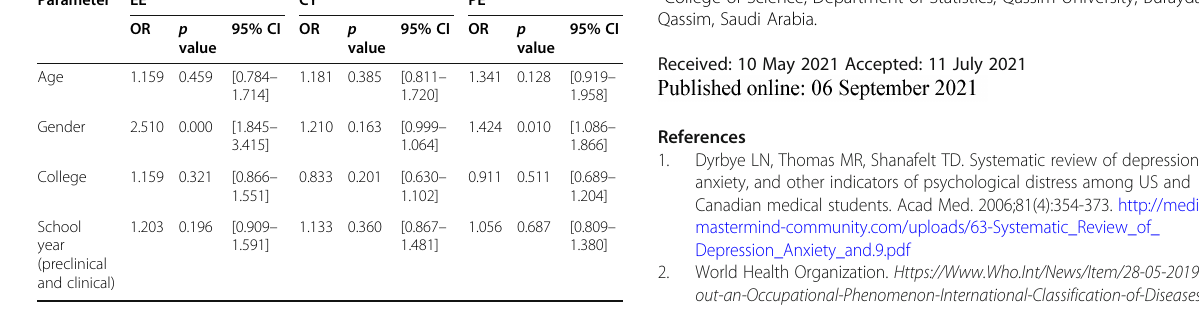
Table 6 Logistic regression analysis for burnout subscales and students ’ demographics Parameter